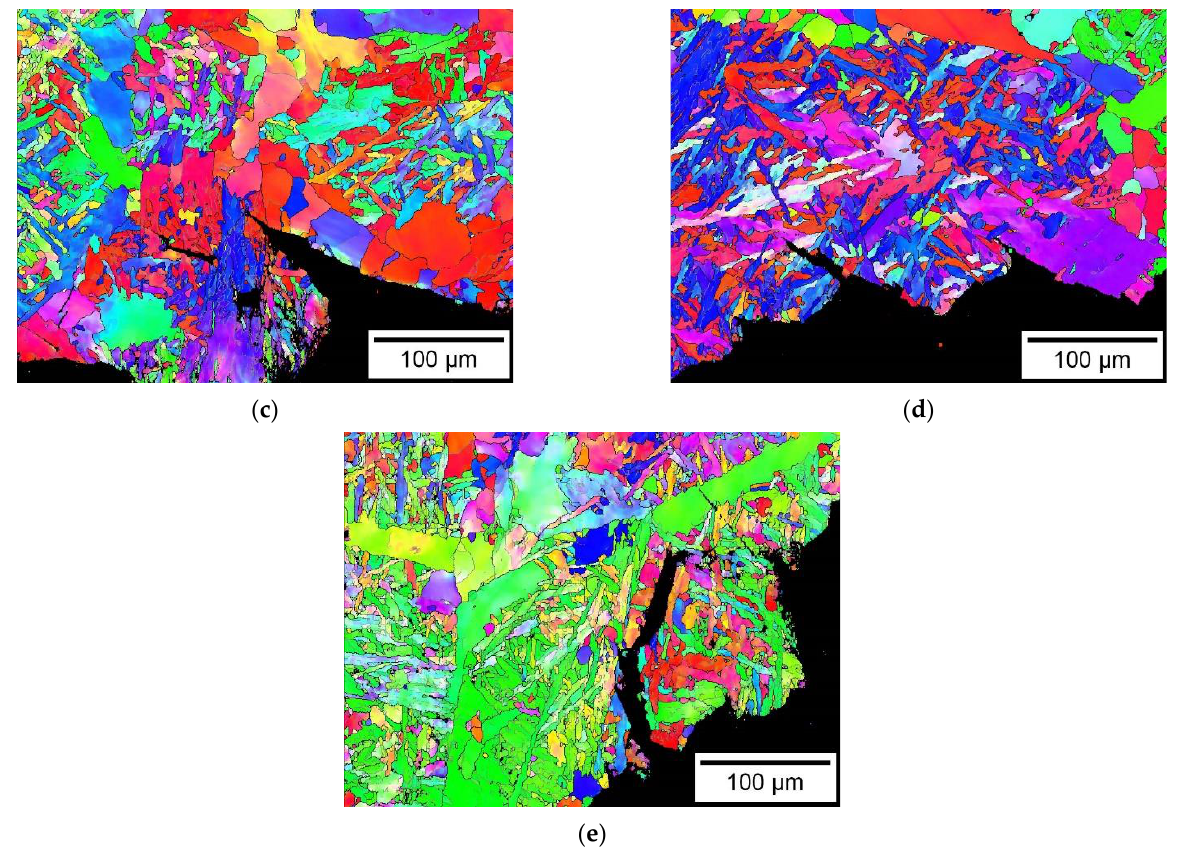
Figure 8. EBSD maps showing the crack propagation of the CGHAZs of ( a ) 2Ca, ( b ) 11Ca-1, ( c ) 11Ca-2, ( d ) 18Ca-1 and ( e ) 18Ca-2 steels after large-heat-input welding at 400 kJ cm − 1 .